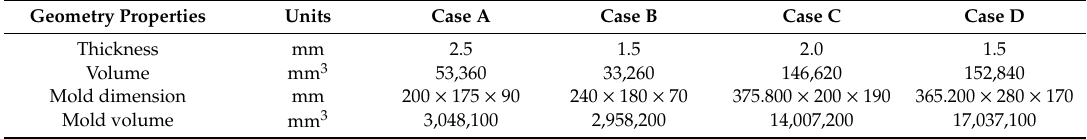
Table 8. Geometry properties of the plastic